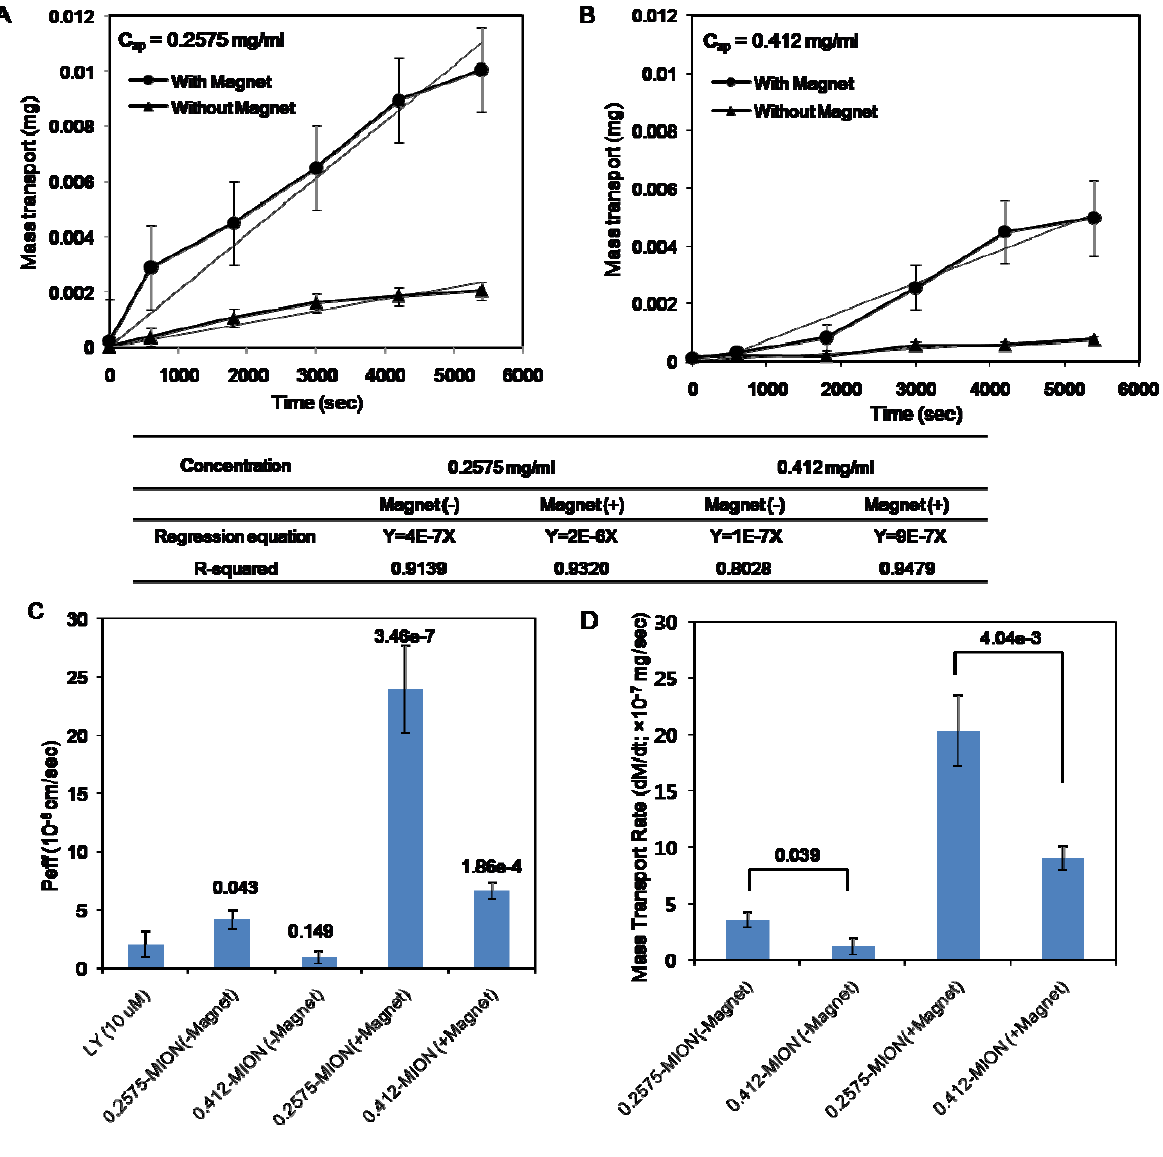
Figure 4. Quantitative analysis of apical-to-basolateral (AP-to-BL) mass transport of Hep- MION across MDCK cell monolayers. Transport experiments across confluent monolayers were performed with Hep-MION dispersions at 0.2575 (A) or 0.412 mg/mL (B) in HBSS with 10% FBS. Experiments were performed in triplicates and standard error bars are shown. Equations and R 2 values of the regression lines of mass transport as a function of time for the apical concentration (C ; 0.2575 and 0.412 mg/mL) are displayed in the table. ap (C) The permeability coefficient, P values of the nanoparticles (C ; 0.2575 and eff ap 0.412 mg/mL) were compared with the permeability of Lucifer Yellow (LY). P-values of t- test results are indicated over the each bar. (D) The mass transport rates ( dM/dt ) of the nanoparticles (C ; 0.2575 and 0.412 mg/mL) were displayed with p-values of t-test results ap to show the different effects of concentration of Hep-MION on the transcellular transport in the presence or absence of the applied magnetic